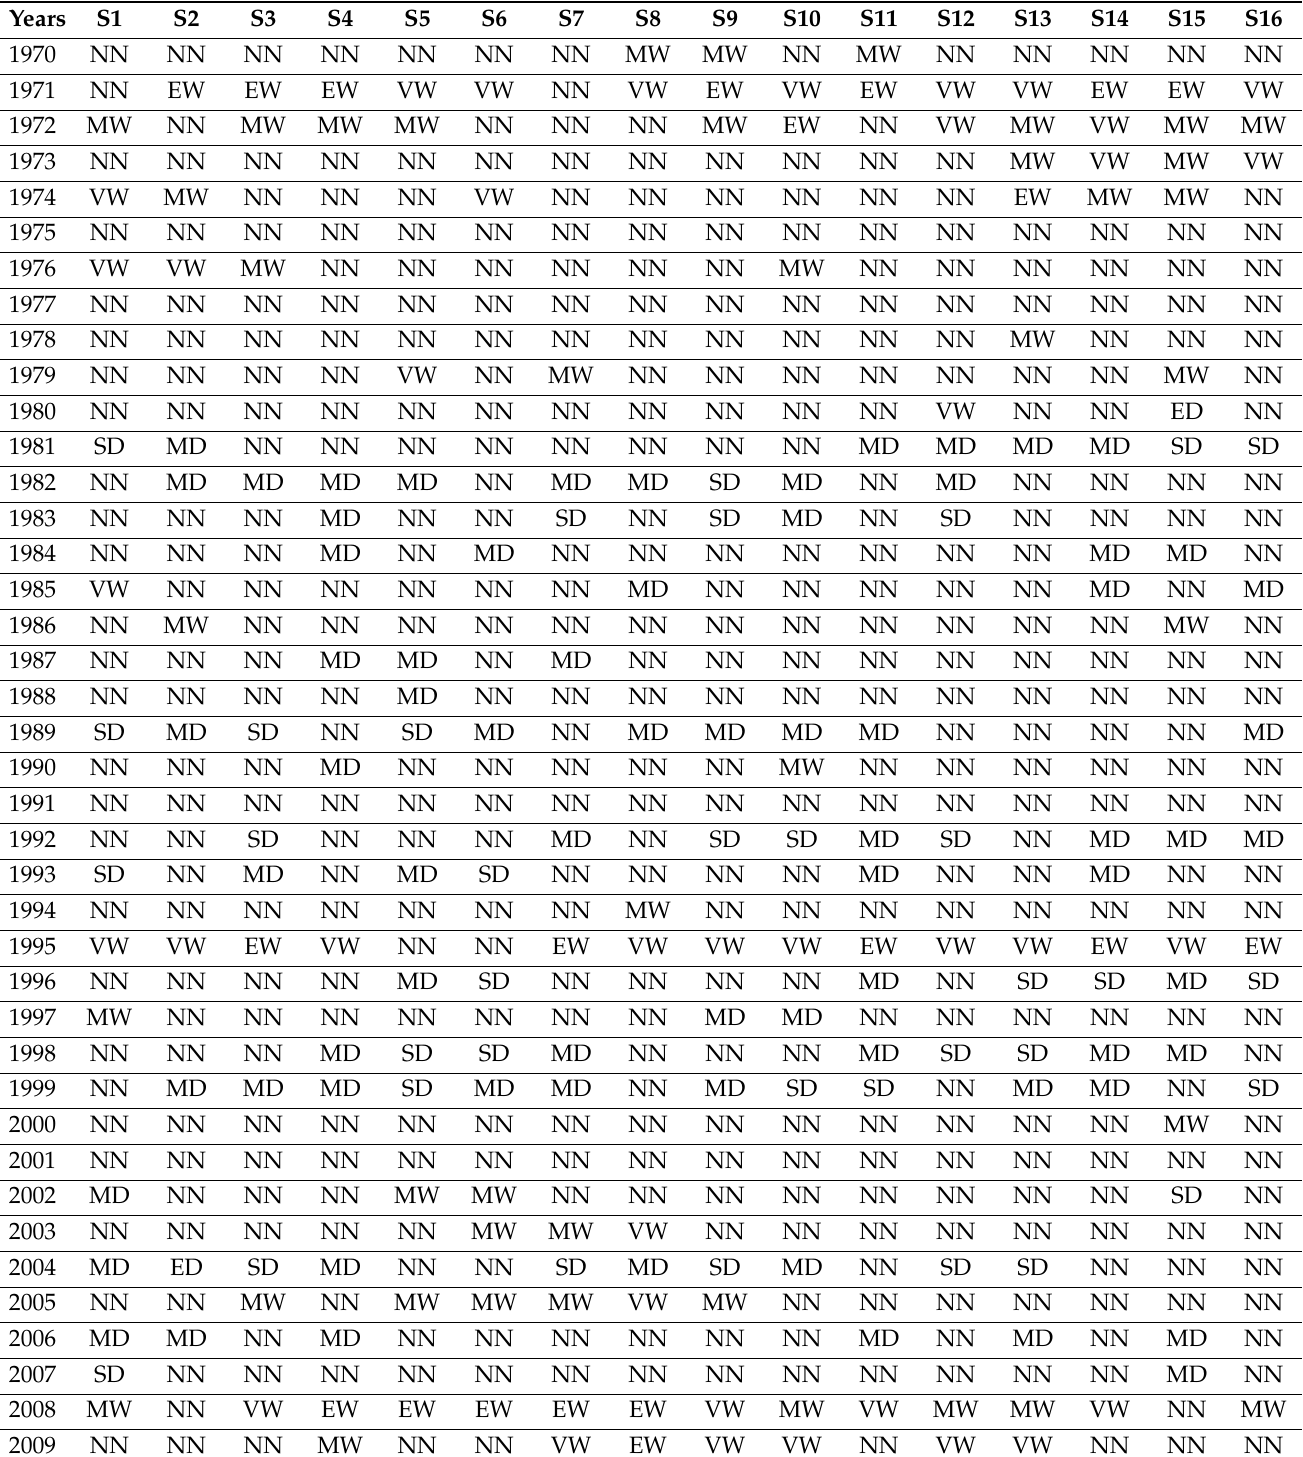
Table 1. Drought classification in the Wadi Mina